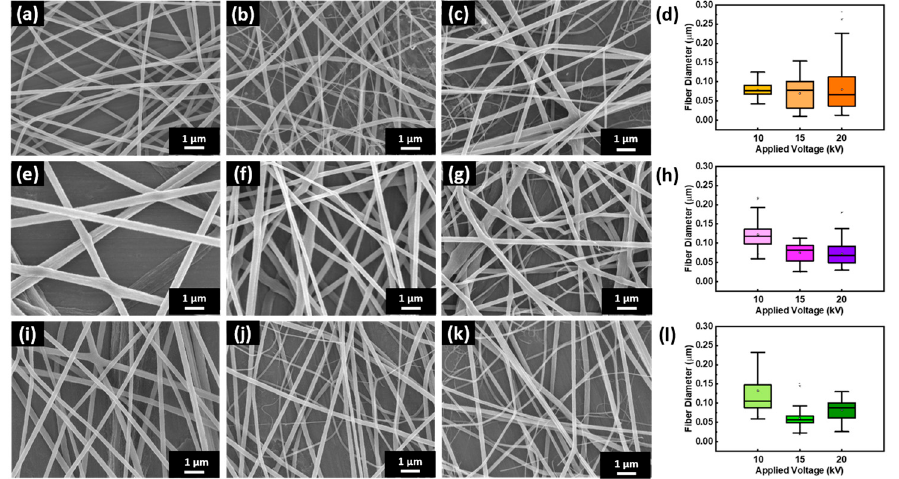
Figure 1. ( a ) The schematic of sensing material preparation. ( b − 1, c − 1, d − 1 − ) TEM image, ( b − 2, c − 2, d − 2 ) the percentage distribution of particles sizes, and ( b − 3, c − 3, d − 3 ) UV–vis absorbance spectrum